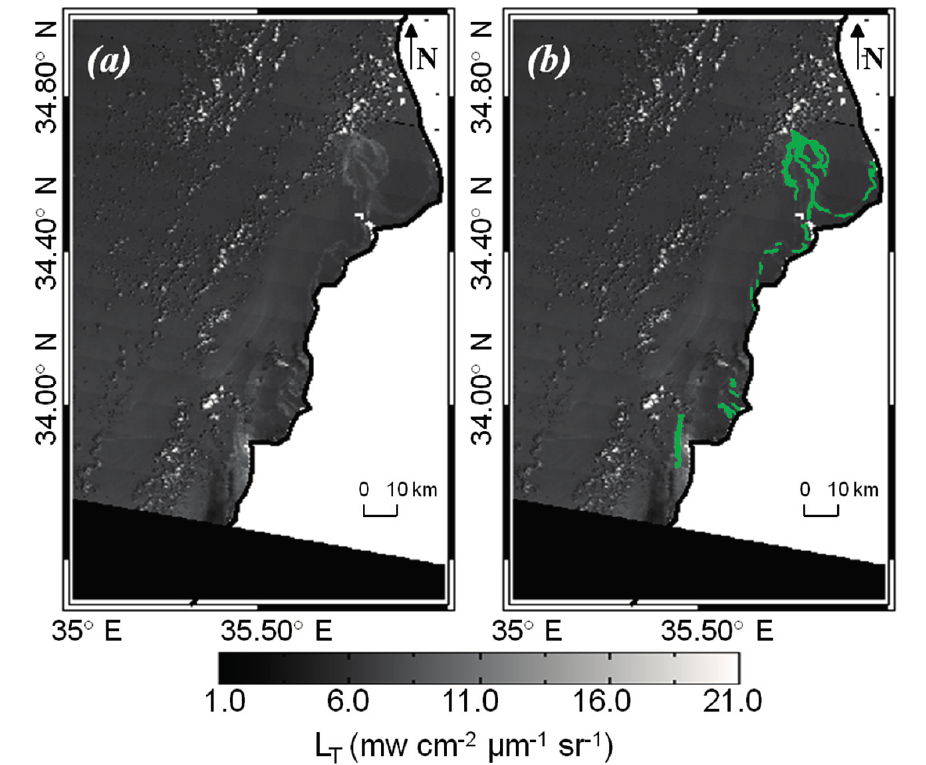
Figure 1. ( a ) MODIS TERRA TOA radiance image, Lt ( 859 nm) . 23 July 2006, 08:35 UTC, Lebanon coast (Scene 2 of Table 1): oil spills are brighter than the surrounding water (positive oil-water contrast); ( b ) the same image with manually-digitized oil spill pixels (ROIs, green regions). The black area indicates the swath’s